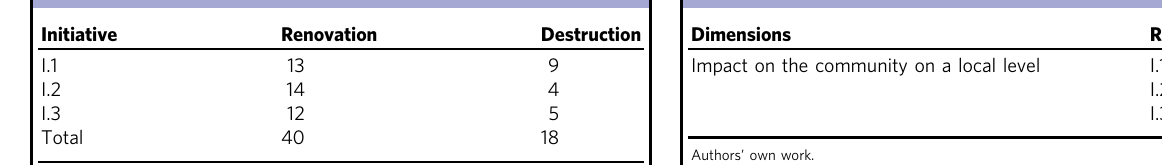
Table 20 Renovation or destruction of a ruined building for each